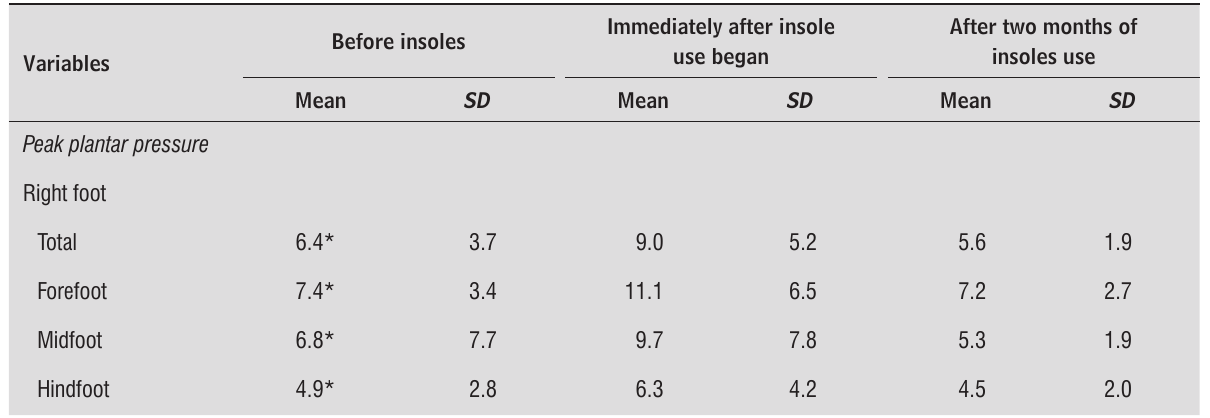
Table 3 - Means and standard deviations (SD) of the peaks of plantar pressure and the total area of plantar contact of the obese subjects, according to the stage of the study. Joinville, SC, Brazil, 2010